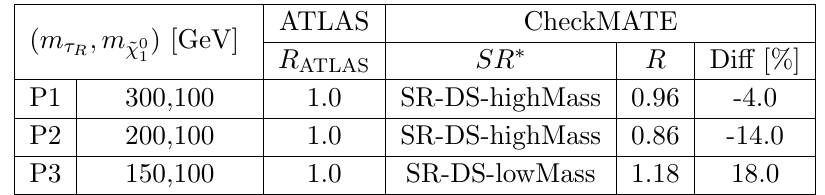
Table 6 . Similar to table 4, but for the ~ (cid:28) R ~ (cid:28) R production process with the corresponding ATLAS results plotted in (cid:12)gure 8a of